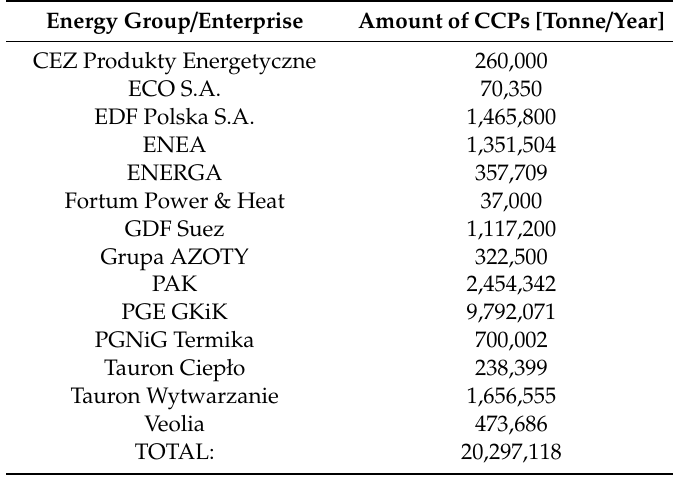
Table 1. Amount of coal combustion products (CCPs) generated in Poland in 2016 in enterprises and energy groups